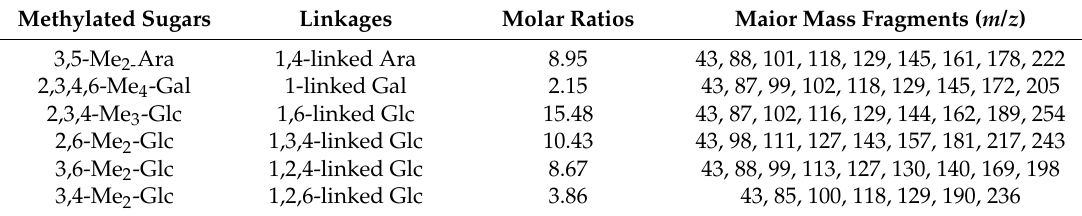
Table 1. Methylation results of DRP1.